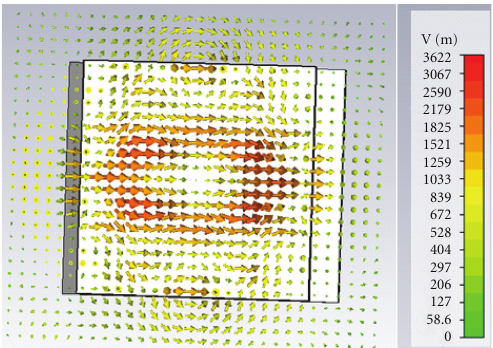
Figure 8: Electric-field distribution on the upper face of the superstrate at 60 GHz.